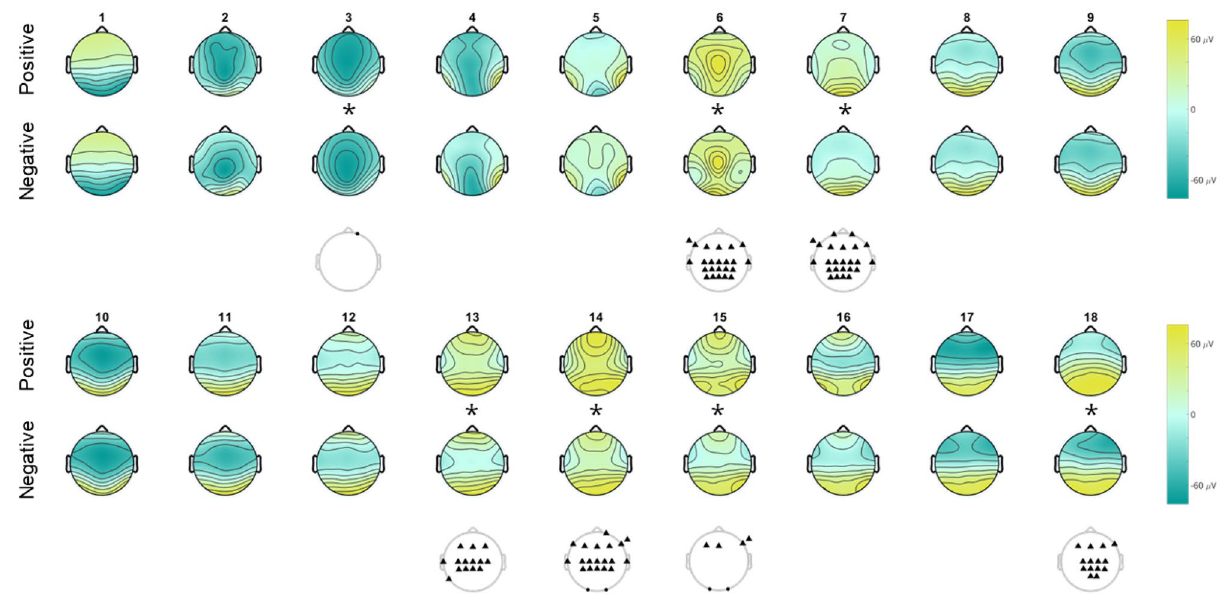
Figure 5. Global and local microstate differences between actively viewing positive and negative pictures. Head seen from above, nose up. Microstates are numbered 1–18. Significant global differences indicated by * ( p adj < 0.001). Electrodes with local differences are plotted below the microstate pair, ▲ indicates higher values in Active Viewing Positive, ● indicates lower values in Active Viewing Positive, all p adj < 0.0017. Colors range from − 76 μV (teal) to + 76 μV